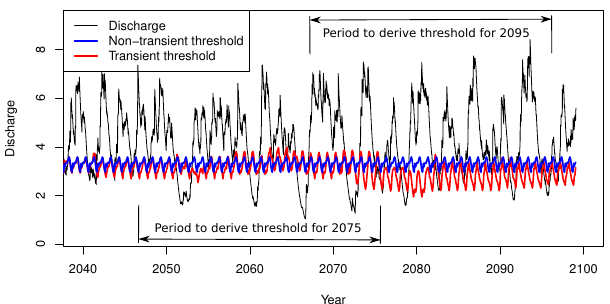
Figure 1. Example time series with schematic overview of the non- stationary variable threshold (VTM), which is constant over the 21st century, and the stationary variable threshold (VTM t ) that considers the gradually changing future hydrological